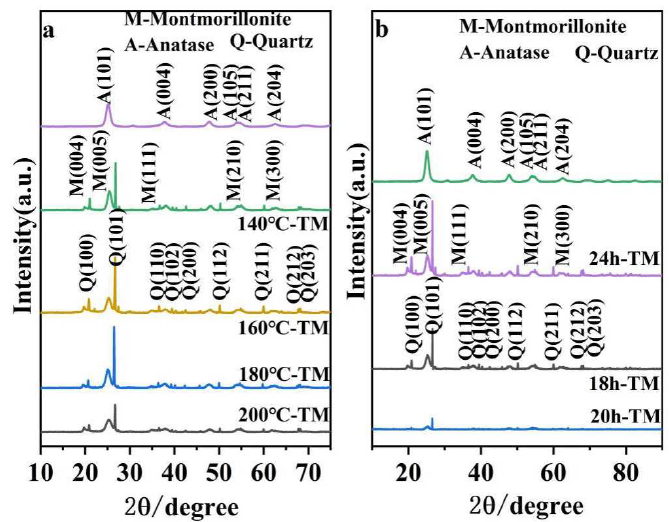
Figure 2. X-ray diffraction patterns of TiO 2 -montmorillonite (MMT) composites prepared using ( a ) different reaction temperatures with a dwelling time of 24 h, a pH of 6, and a TiO 2 mass ratio of 30 wt%, and ( b ) different dwelling times at a reaction temperature of 160 °C, a pH of 6, and a TiO 2 mass ratio of 30 wt%.